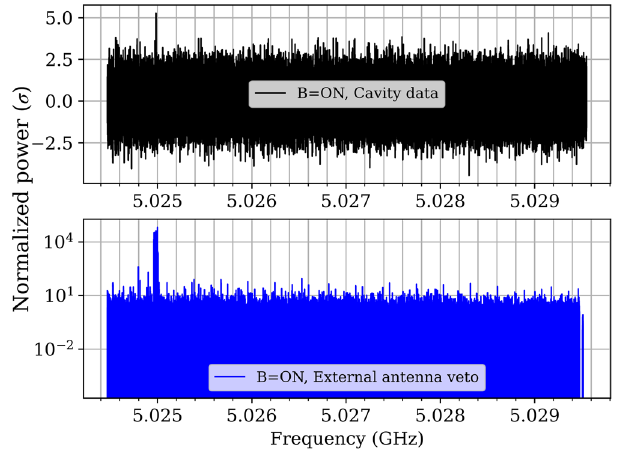
Fig. 3 | An example of comparison of daily combined spectra between cavity (upper fi gure) and EMI/EMC channel (lower fi gure) both being equally pro- cessed. If a parasitic signal appears in both channels it is excluded from further consideration as an axion